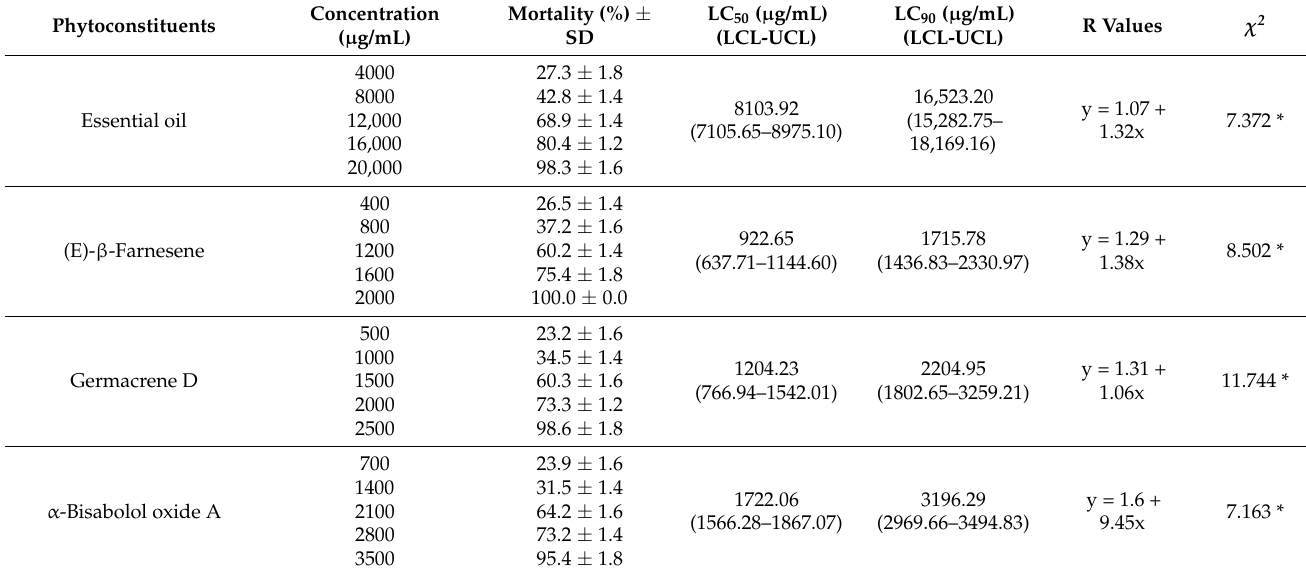
Table 6. The effect of Matricaria chamomilla essential oil and its major phytoconstituents against terrestrial non-target fauna (NTF) Stegodyphus sarasinorum .